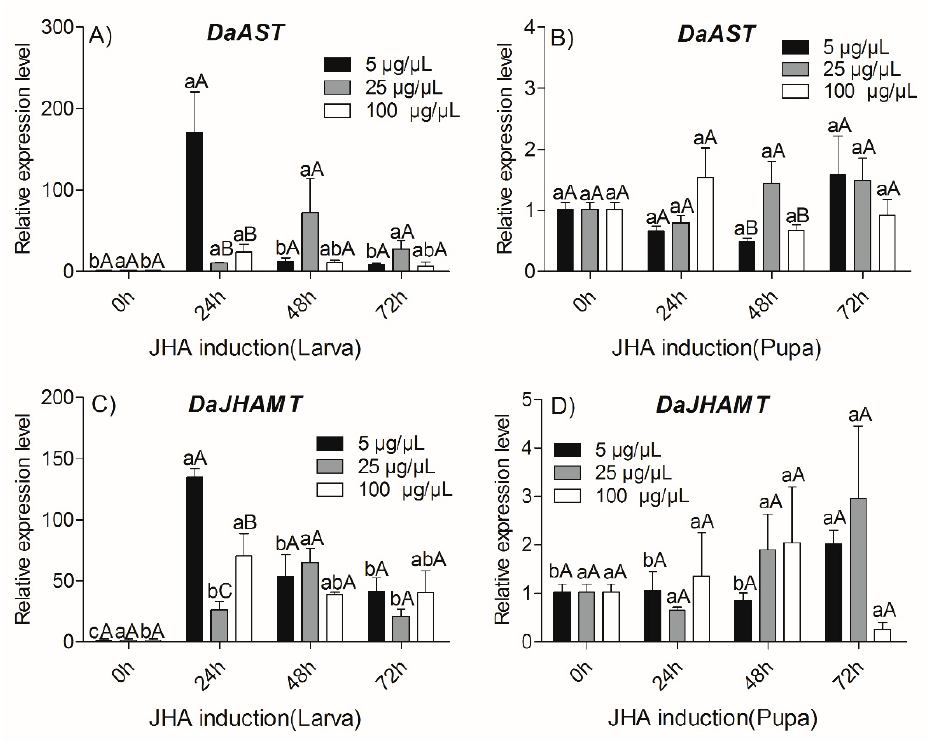
Figure 5. Relative expression of DaAST and DaJHAMT genes with JHA (5, 25, 100 µg/µL) at different times in larvae and pupae. ( A ) DaAST mRNA level in larvae; ( B ) DaAST mRNA level in pupae; ( C ) DaJHAMT mRNA level in larvae and ( D ) DaJHAMT mRNA level in pupae. The results represent the means ± SE of three independent experiments. In all graphs, the transcript levels are shown relative to acetone-treated (control) larvae and pupae. All templates were normalized with CYP4G55 and β -actin . The 2 − ∆∆ Ct and SE values were used for plotting. Different letters indicate significant differences at p < 0.05 (two-way ANOVA). Uppercase letters mark significant differences between concentrations at the same time, while lowercase letters mark the significant differences between times at the same concentration.